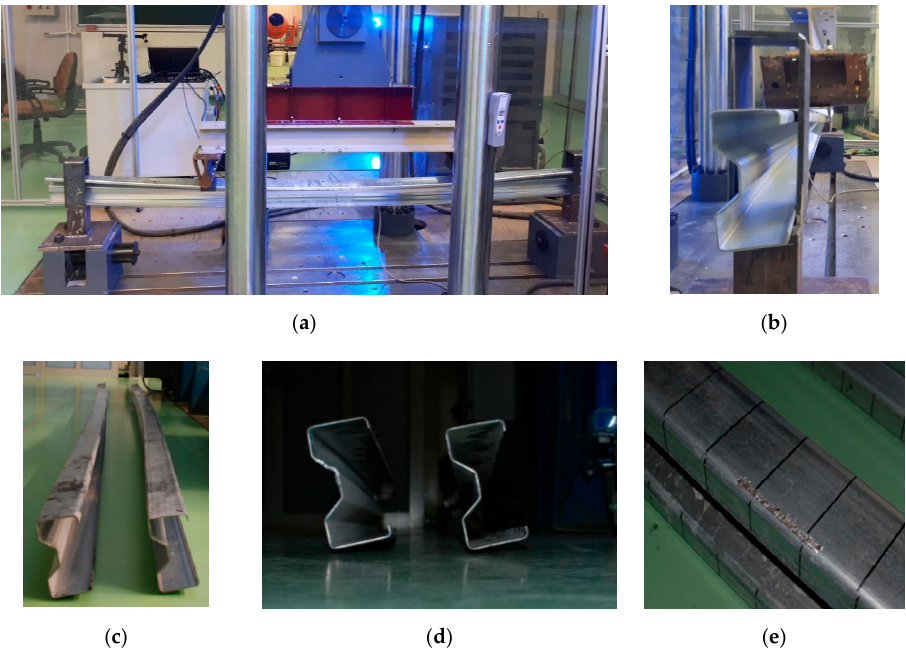
Figure 5. Failure mode of the beams of the third test stage: ( a , b ) beams in the loading phase, ( c , d ) beam failure modes, ( e ) local damage of the beam after the test scratch at the place of load application. Examples of the displacements of measuring points of the selected sample in the middle of its span obtained with a load of 25 kN are presented in Figure 6.